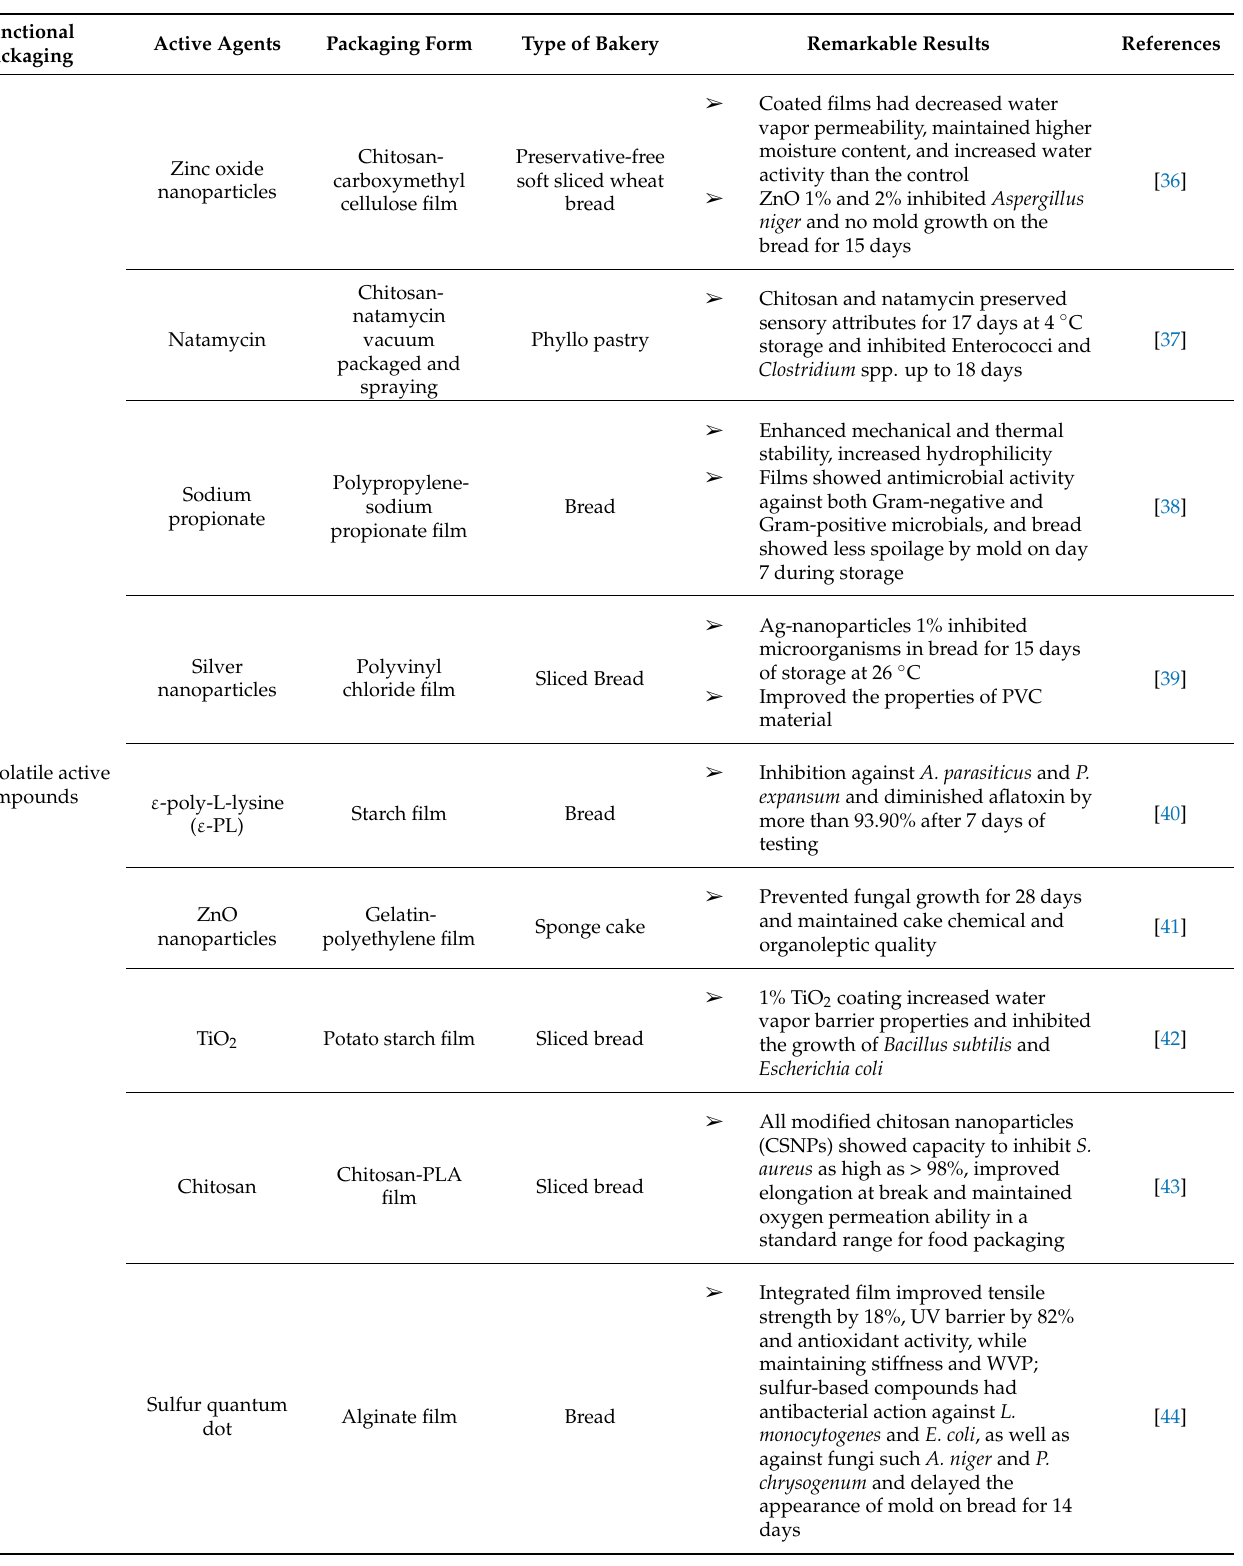
Table 1. Functional polymers and packaging technology for bakery